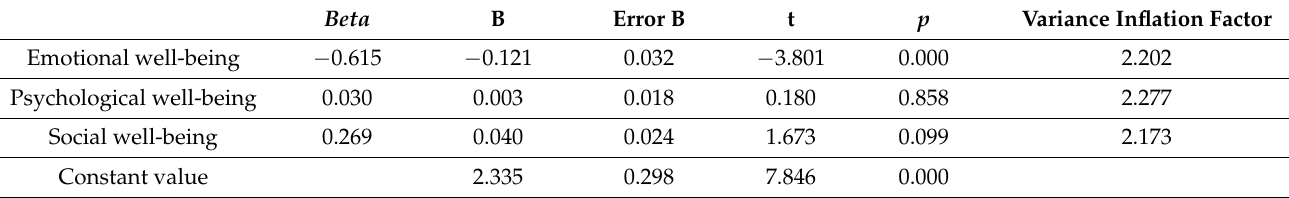
Table 8. PTSD predictors (individuals with no diagnosis) ( n = 70 in each group).